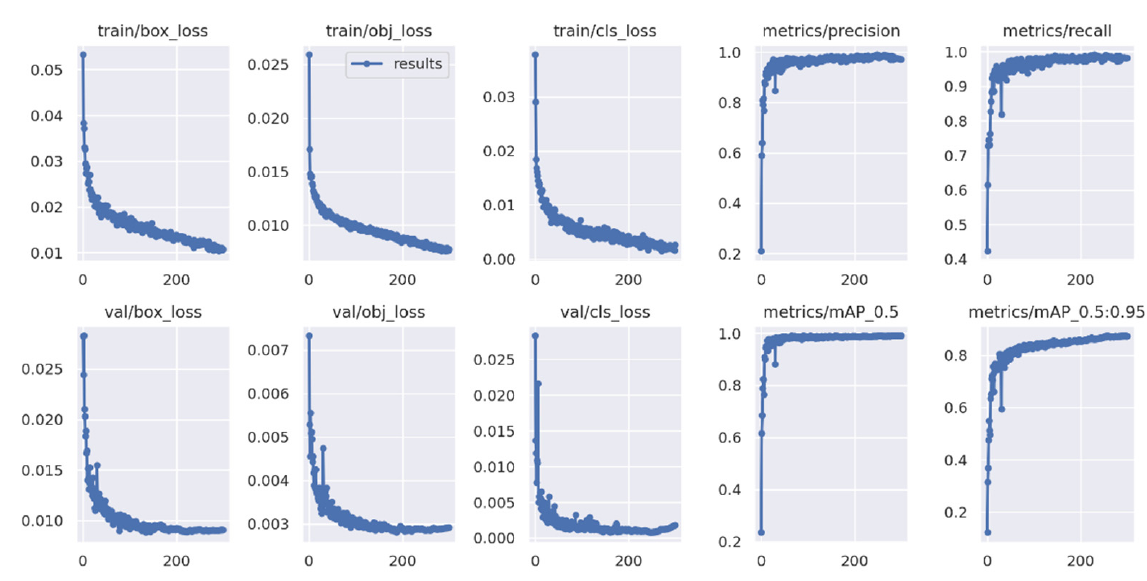
Figure 16. Integration results of YOLOv5s (300 epochs). Table 2. Performance comparisons of different deep learning algorithms.